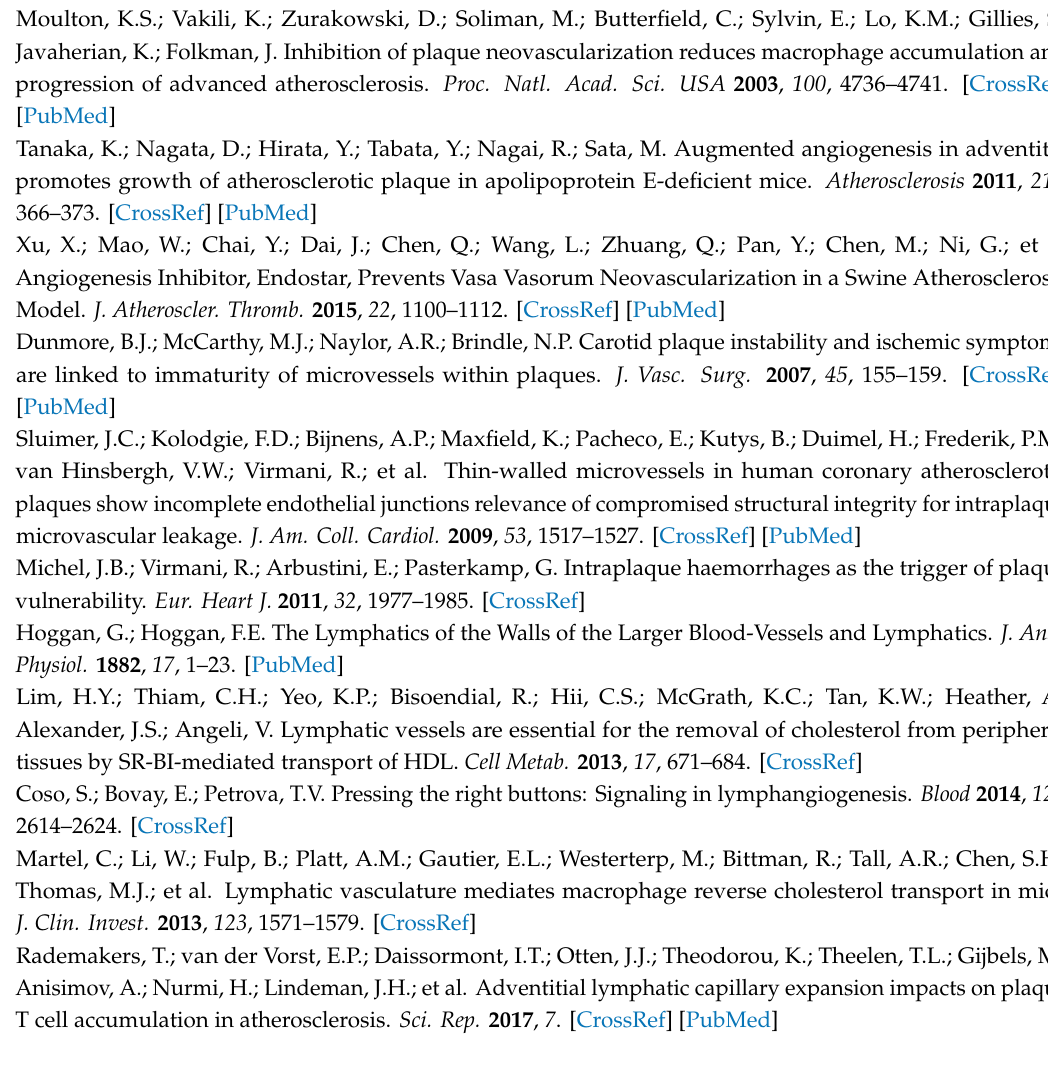
Figure S1: Immunohistochemical analysis of PVAT: negative controls; Figure S2: Cytokine antibody array map; Figure S3: Quantitative analysis of protein expression in PVAT using cytokine antibody arrays; Figure S4: Analysis of paracrine e ff ects of PVAT-derived conditioned medium on human dermal lymphatic endothelial cells; Figure S5: Flow cytometry analysis of (lymphatic) endothelial cell markers in HDLECs; Table S1: Primer sequences used for gene expression analysis of human